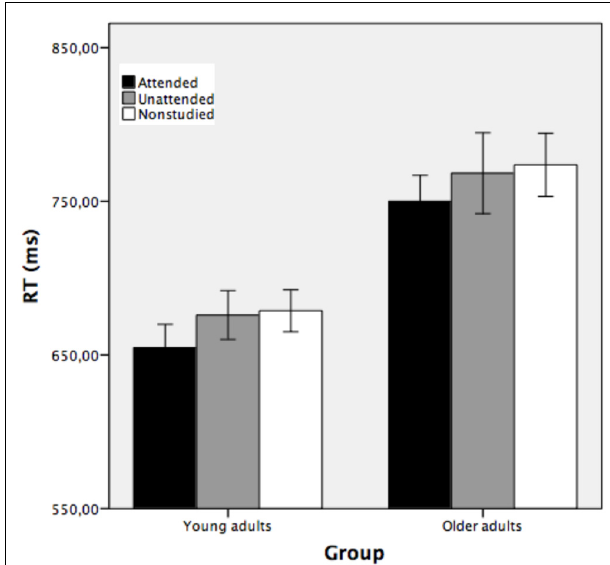
FIGURE 4 | Mean reaction time (in ms) obtained in the conceptual implicit memory task as a function of group (young and older adults), corresponding to attended, unattended and non-studied picture outlines (Experimrnt 1). Bars indicate ± 1 SD from the mean.